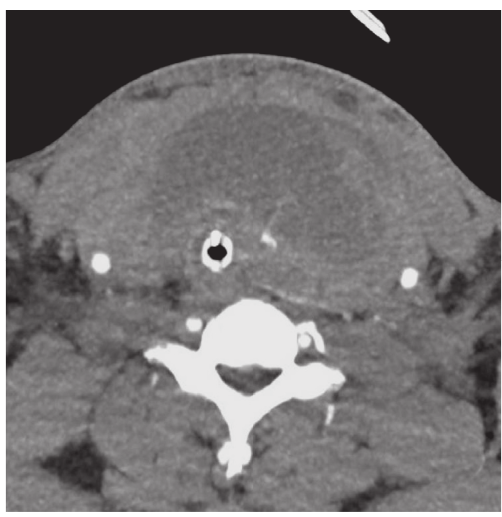
Figure 1: Axial CTA scan demonstrating thyroid hematoma and collapsed trachea with arterial blush concerning for active hem- orrhage in the thyroid parenchyma.